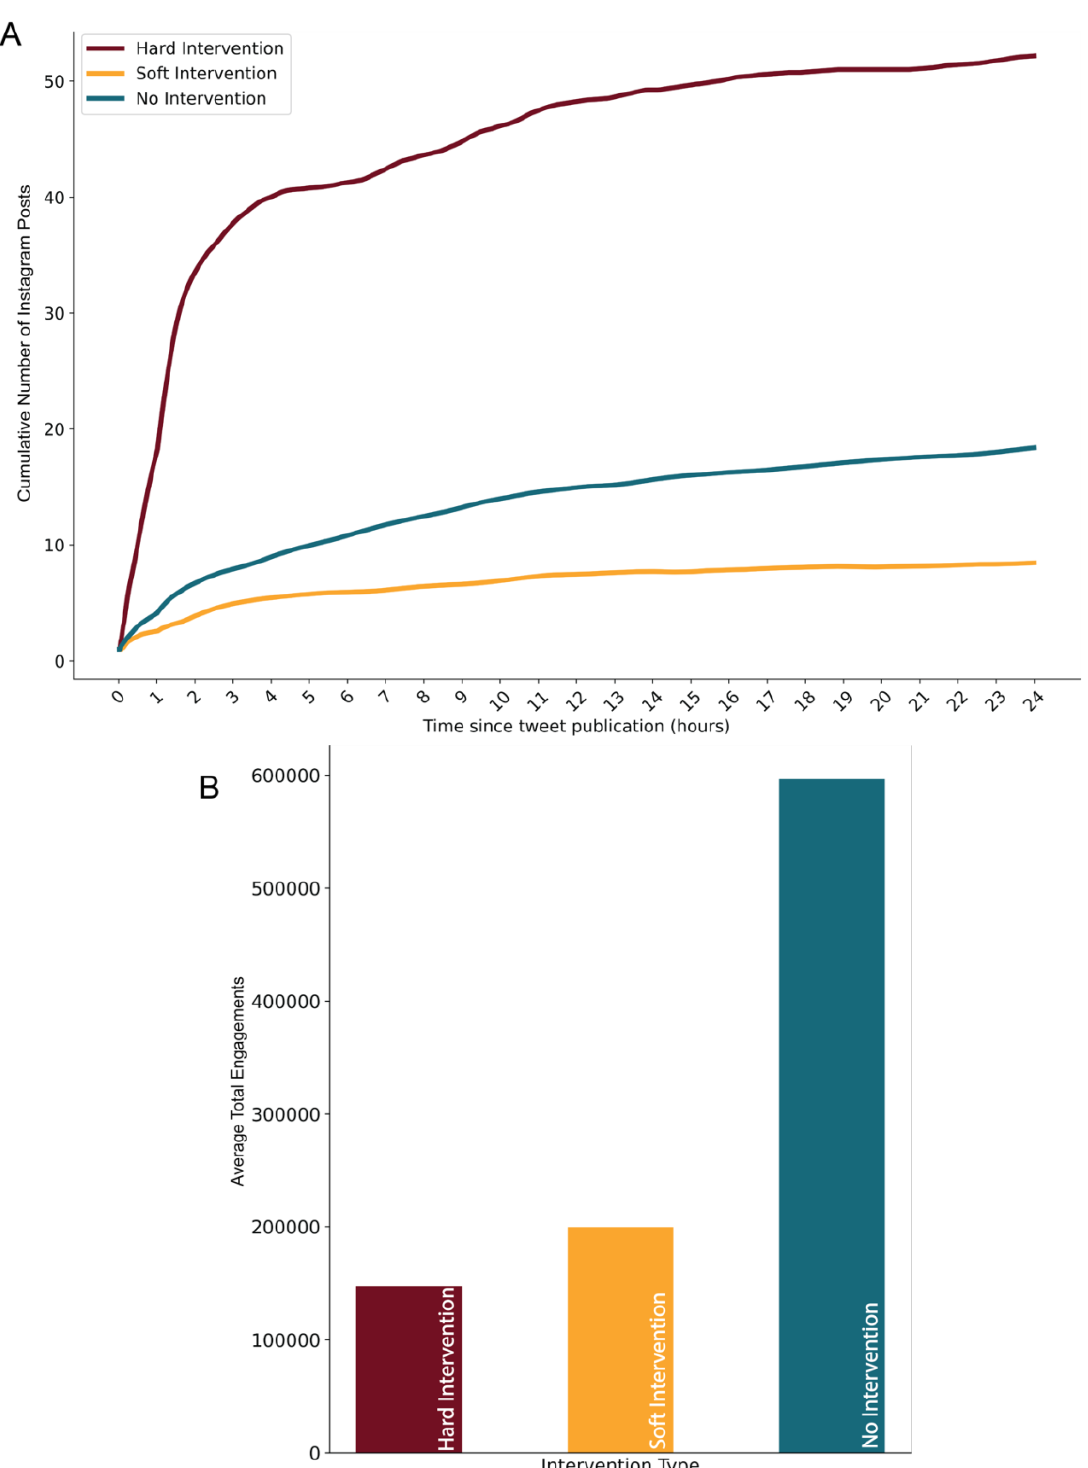
Figure 4. Trajectory and engagement of tweets on Instagram by intervention type. We first group all messages by the type of intervention they received on Twitter (hard intervention, soft intervention, or no intervention). (a) Growth of Instagram posts by intervention: we plot the cumulative number of posts (y-axis) over time (x-axis) averaged over all of the messages in each category. (b) Engagement per post on Instagram by intervention on Twitter: we measure the average number of engagements for posts that contained the messages in each